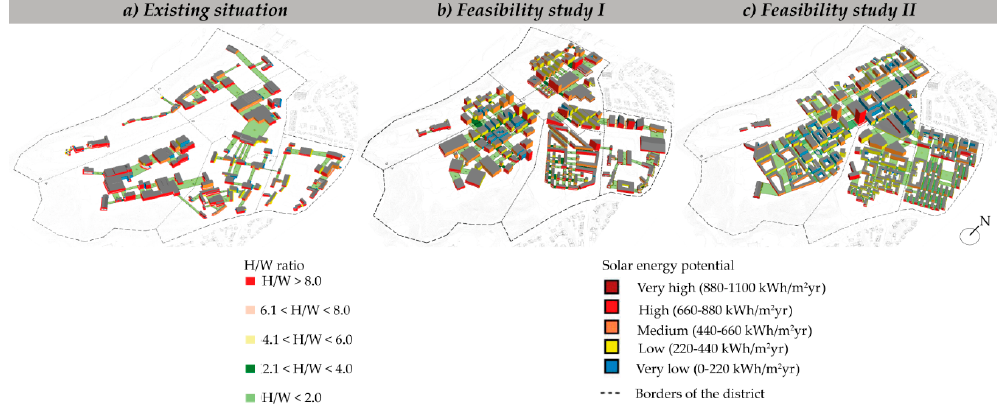
Figure 13. Solar potential of the façades depending on H / W ratio in the ( a ) existing situation, Figure 15. Solar potential of the façades depending on H/W ratio in the ( a ) existing situation, ( b ) ( b ) feasibility study I, and ( c ) feasibility study II. feasibility study I, and ( c ) feasibility study II.